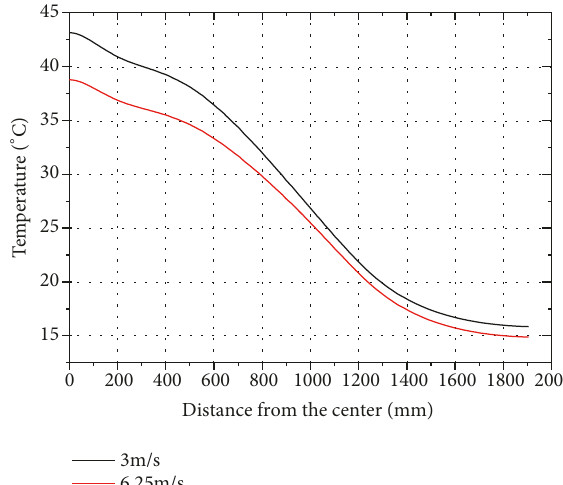
Figure 26: The temperature contrast of bottom plate between Test B1 and FS1.